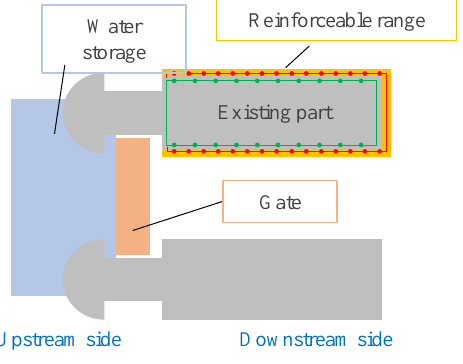
Figure 2. Reinforceable range.